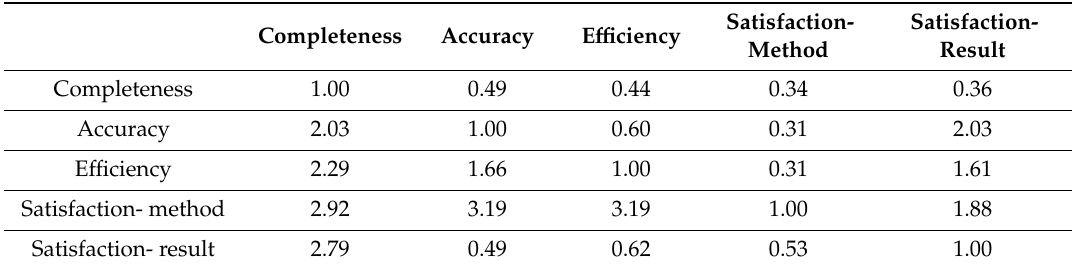
Table 5. Pairwise comparison of the criteria for the comparison of the two